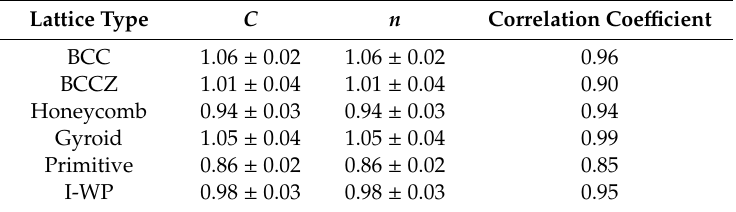
Table4. Porousstructuralconstant( C and n )andthefittedcorrelationcoefficientR 2